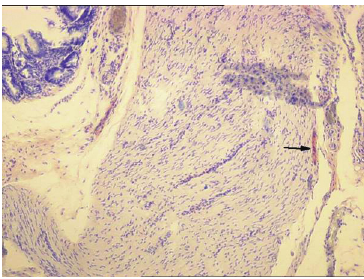
Figure 3 - The arrow indicates the microscopic appearance of nerve fibers in the adhesion between the cecum and the omentum in Group 1